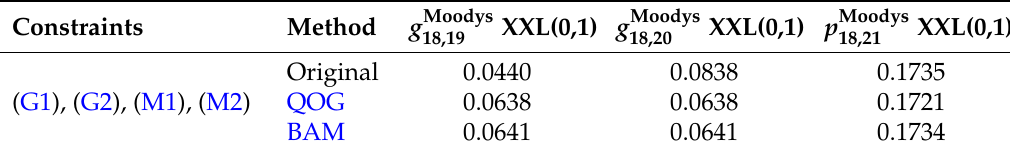
Table 5. Corrections of the additional Constraints (M1) and (M2) and their impact on the default probabilities of QOG and BAM, for transition matrix P Moodys XXL ( 0,1 ) in Table